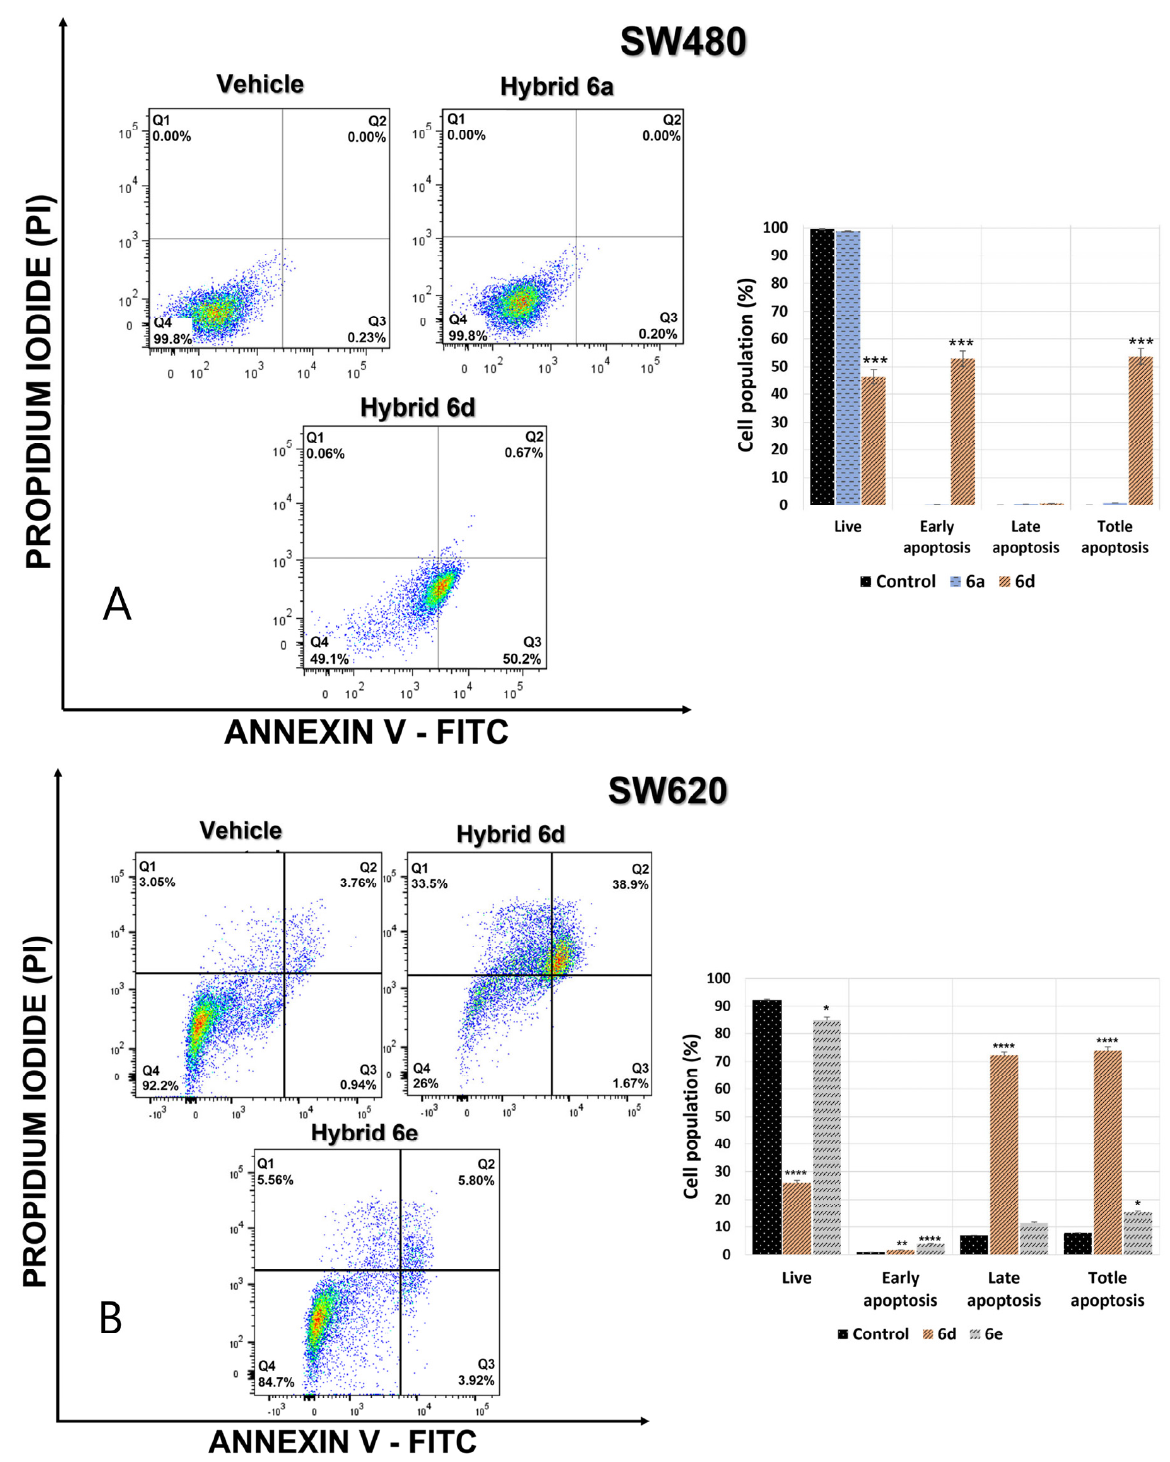
Figure 9. Apoptosis of SW480 ( A ) and SW620 ( B ) cells following treatment with the hybrid compounds 6a , 6d , and 6e . The histograms represent one of at least two different experiments. Q1 + Q2: Cells that lost membrane integrity (late apoptotic cells, dead cells, necroptotic cells, sec- ondary necrotic cells, others); Q3: Early apoptotic cells; Q4: Viable cells. Data are presented as the mean of these two populations ± SE of three independent experiments. p -values lower than 0.05 were considered statistically significant (* p < 0.05; ** p < 0.01; *** p < 0.001; **** p <